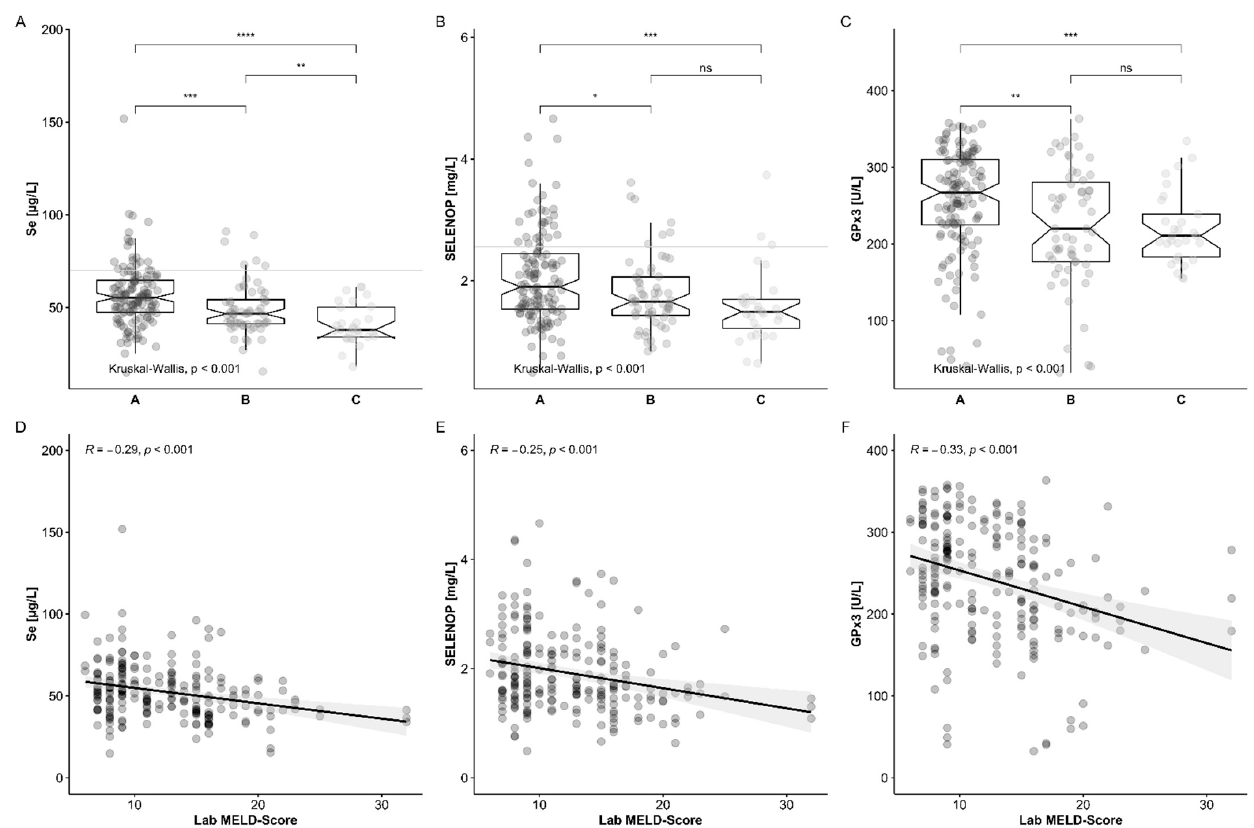
Figure 5. Serum biomarkers of Se status from patients undergoing liver transplantation (LT) at the time of surgery (POD 0) in comparison to established diagnostic scoring systems. All three biomarkers of Se status, i.e., ( A , D ) total serum Se concentrations, ( B , E ) SELENOP levels and ( C , F ) GPx3 activities, showed a significant relation to the Child–Pugh Score (CPS) and the MELD score. The most severe diagnosis (CPS class C) displayed the lowest ( A ) Se concentrations, ( B ) SELENOP levels and ( C ) GPX3 activities. Similarly, the correlation coefficients of the Se biomarkers with the MELD score were consistently negative, and ranged from ( D ) R = − 0.29 for total Se, to ( E ) R = − 0.25 for SELENOP levels and to ( F ) R = − 0.33 for GPX3 activities. Comparisons between groups by Kruskal–Wallis test ( A – C ), and correlation analyses by Spearman analysis; * p < 0.05, ** p < 0.01, ** p < 0.001 and **** p < 0.0001.